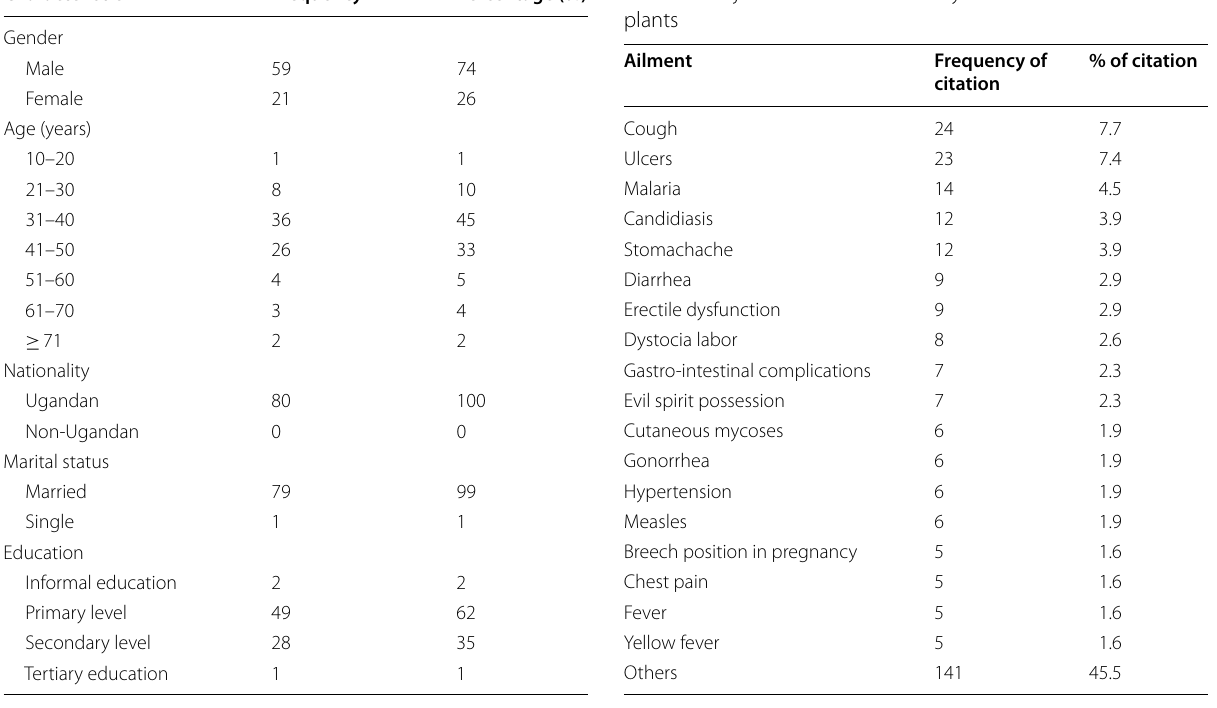
Table 2 Major diseases treated by the identified